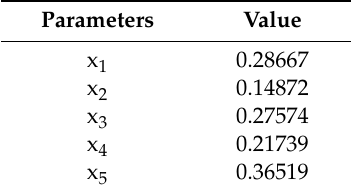
Table 2. Collapse mechanism parameters.